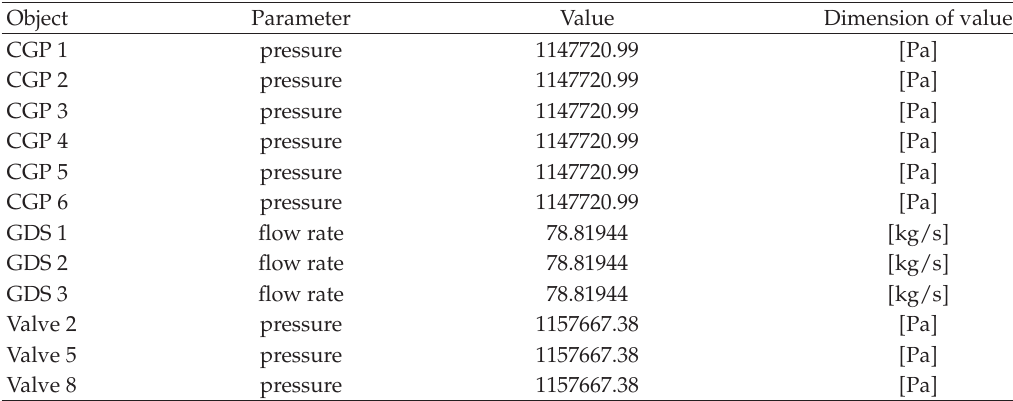
Table 4: Gas flow parameters at identification points.